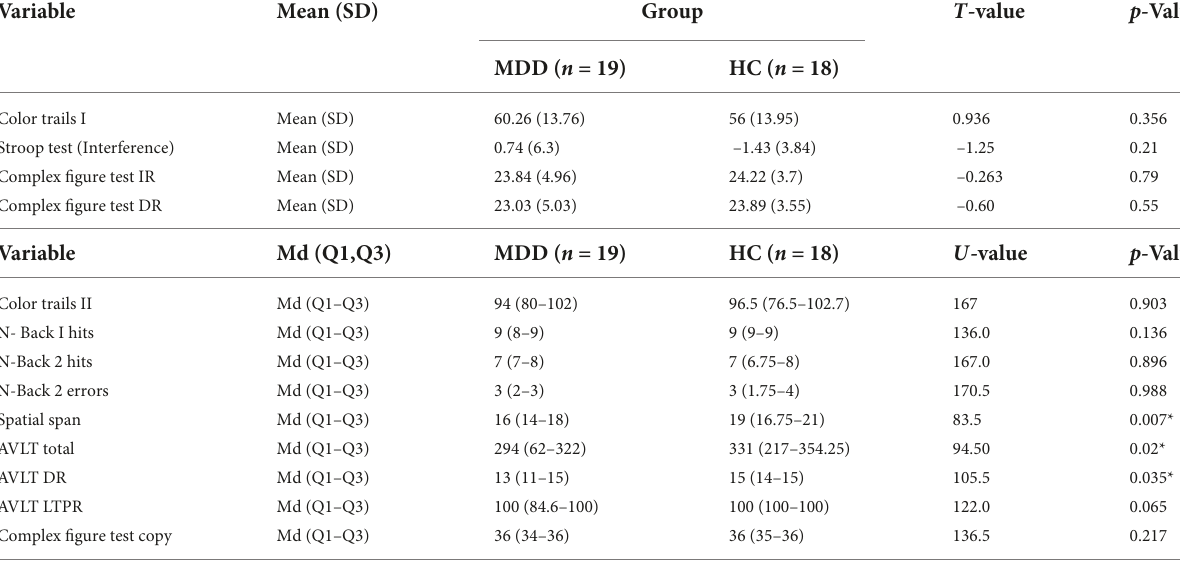
TABLE 3 Comparison between MDD and HC group on various neurocognitive tests.